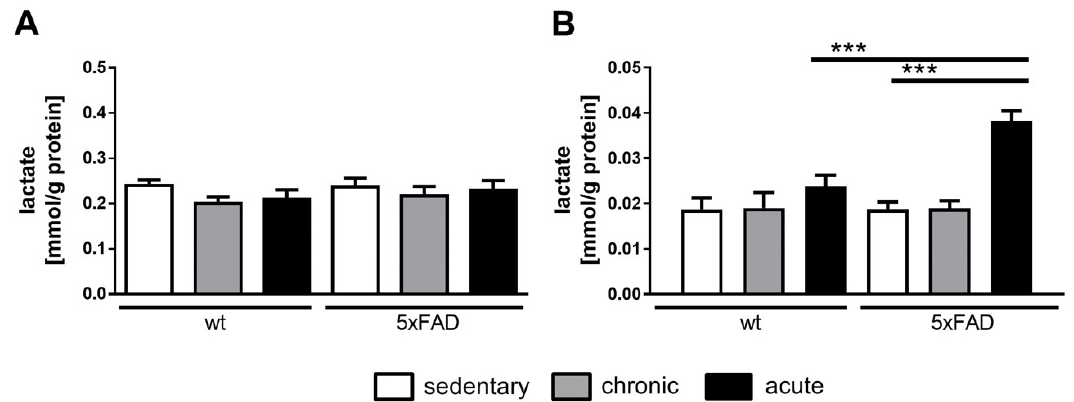
Figure 4. Lactate levels in serum ( A ) and brain tissue ( B ) homogenates of 5xFAD and wild-type mice. Serum and brain homogenate lactate were assessed by an enzymatic assay. Values were normalized to protein content and are presented as mean + SEM ( n = 6 for untrained and acutely trained, n = 7 for chronically trained mice). Statistical analysis: ordinary one-way ANOVA with the Fisher LSD test (*** p < 0.001).